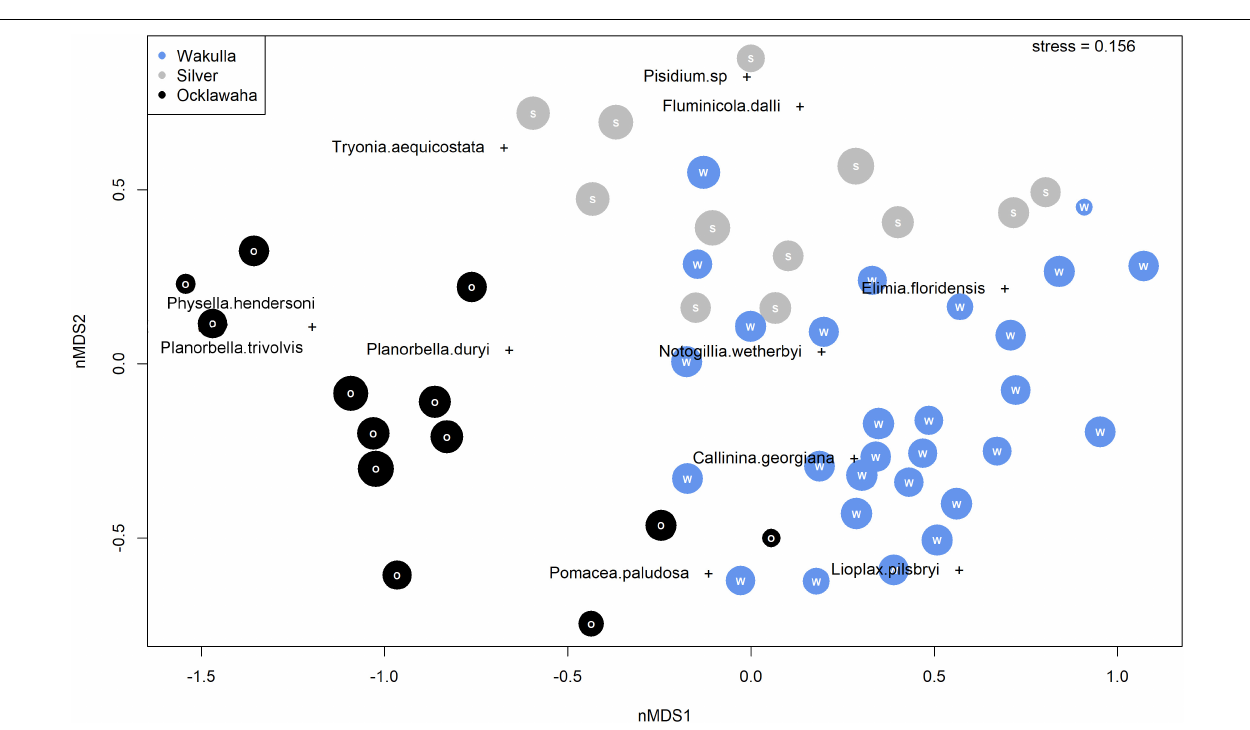
Frontiers in Ecology and Evolution |